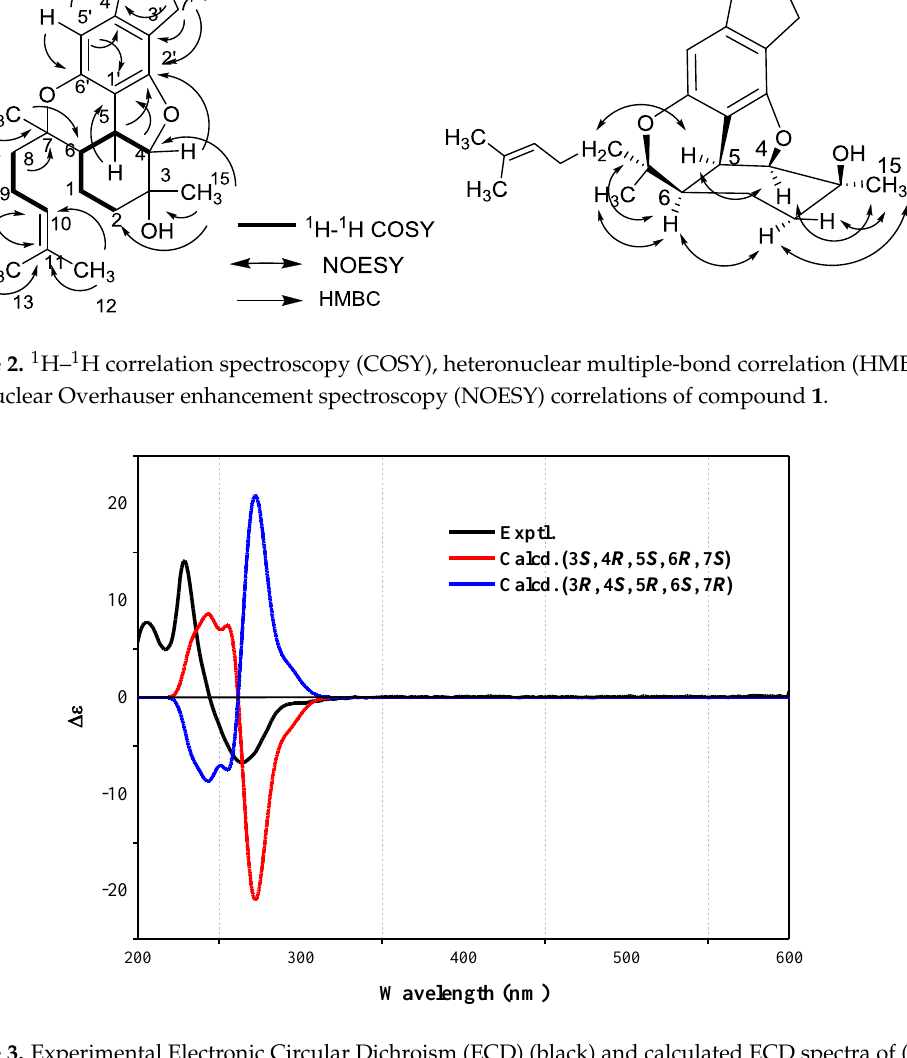
Figure 3. Experimental Electronic Circular Dichroism (ECD) (black) and calculated ECD spectra of (3 S , 4 R , 5 S, 6 R , 7 S )- 1 (red) and (3 R , 4 S , 5 R , 6 S , 7 R )- 1 (blue).